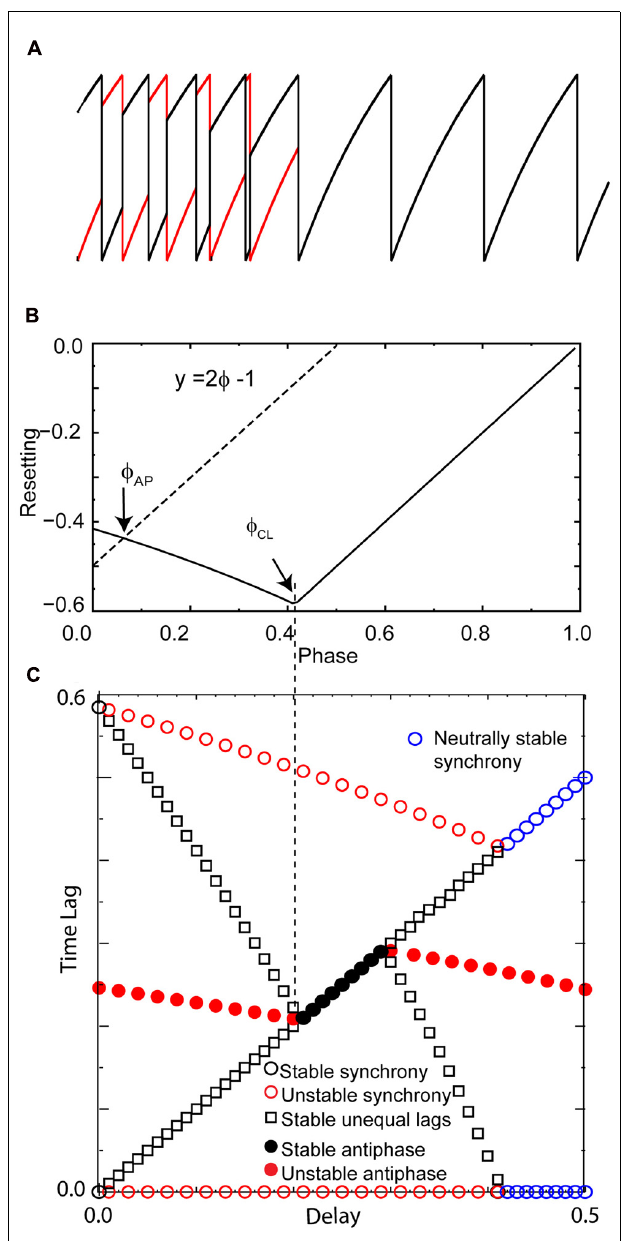
FIGURE 5 | Right skew is not rigorously required for zero lag synchrony or leader–follower modes in excitatory pairs. An extreme example was constructed to show that right skew is not required for these phenomena. Parameters for the coupled LIF pair are γ = 0.9, S 0 = 1, ε = 0.05. (A) Convergence to synchrony with no conduction delay. (B) Left skewed phase resetting curve enters the causal limit region beyond the phase φ CL at about 0.4. Again, the dashed line labeled y = 2 φ − 1 give the input phase for the unstable antiphase mode φ AP with zero delay. (C) Solution structure for delays less than half the intrinsic period shows a stable leader–follower mode with time lags proportional to the delay emanating from synchrony at zero delay.The symbols have the same meaning as in Figure 4 , and all quantities are normalized by the intrinsic